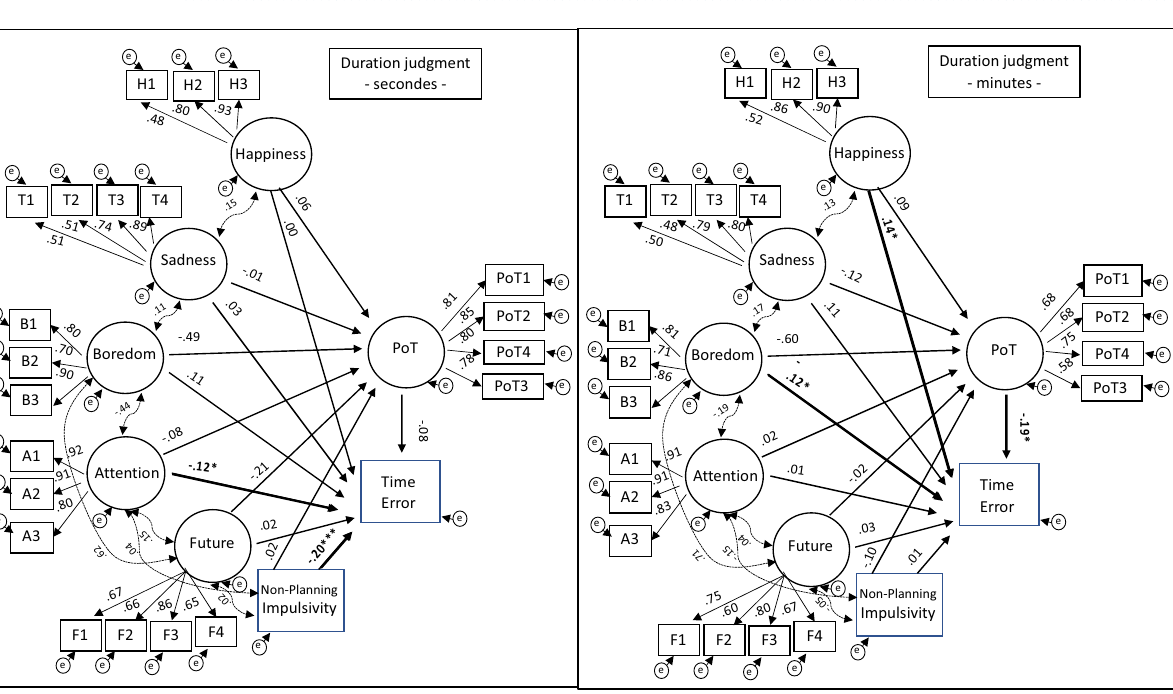
Figure 4. Structural Equation Model analyzing the relationships between variables thought to influence the time error in the verbal duration judgment task for the short (seconds) (left panel) and long (minutes) duration (right